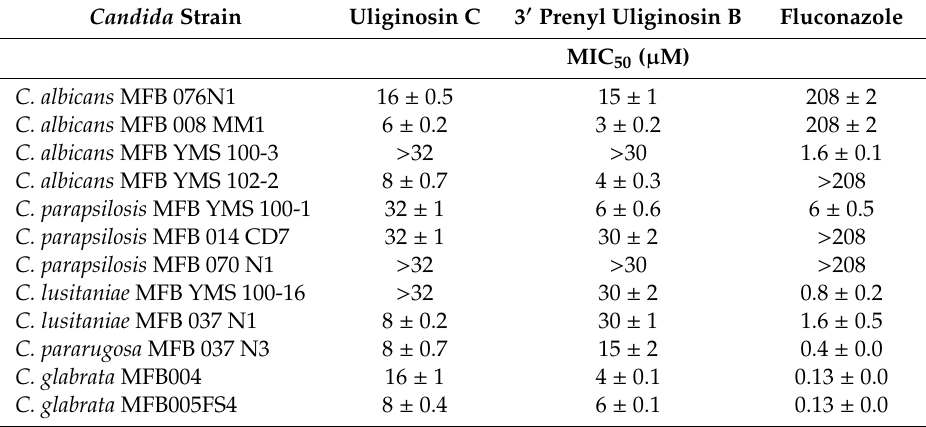
Table 6. Anti- Candida activity of two major isolated